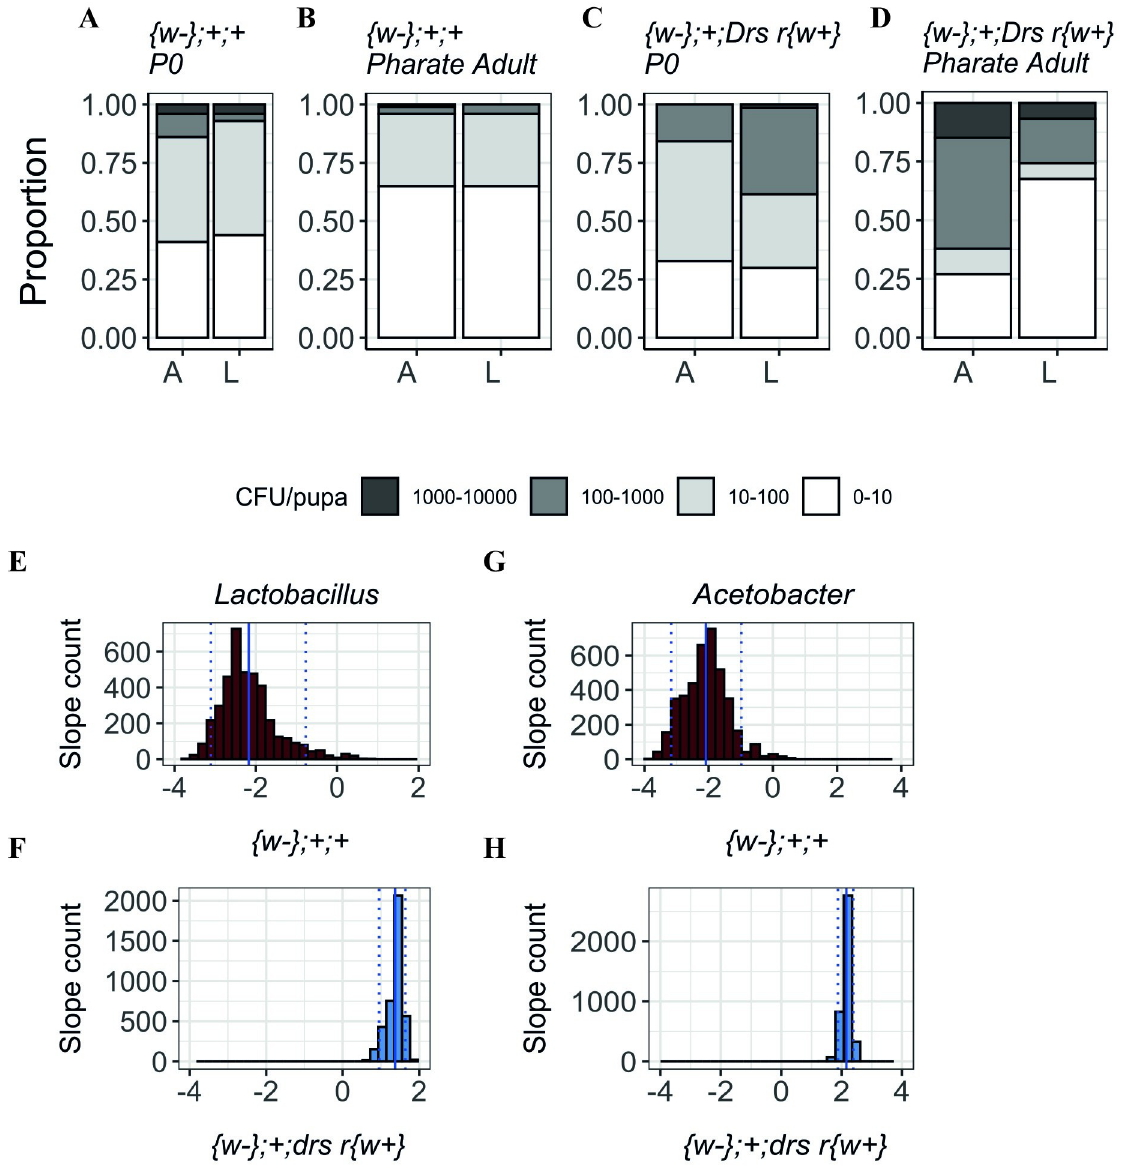
Fig 6. Bacteria quantification ( Lactobacillus (L) and Acetobacter (A)) in P0 pupae and pharate adults in wild-type and drs mutants. (A-B) In control flies ({w-} ;+;+), the number of pupae with more bacteria decreases between P0 and pharate adult stages. (C-D) In the drs mutant line ({w-} ;+; Drs r{w+}), there are more individuals with higher loads of bacteria persisting from P0 to pharate adult. (E-F) Slopes for the number of Lactobacilli in control and the mutant lines. (E) Control samples have negative slopes indicating a decrease in the number of bacteria between stages ( Median : -2 . 308 (IQR : -2 . 619; -1 . 880 ); One-way Wilcoxon test for median0: < 2.2e-16, r = 0.865). (F) drs mutant samples have positive slope values, representative of an increase in the number of bacteria across metamorphosis ( Median : 1 . 408 (IQR : 1 . 286; 1 . 498); One-way Wilcoxon test for median > 0 : < 2 . 2e-16 , r = 0 . 866 ). (G) Control samples distribution show negative slopes, i.e., a decrease in the number of bacteria between stages ( Median : -2 . 0 . 757 (IQR : -2 . 5721; -1 . 7128); One-way Wilcoxon test for median < 0 : < 2 . 2e-16 , r = 0 . 866 ). (H) drs null mutant displays positive slope values ( Median : 2 . 165 (IQR : 2 . 077; 2 . 247); One-way Wilcoxon test for median > 0 : < 2 . 2e-16 , r = 0 . 866 ). Doted lines represent the 0.05 and 0.95 quantiles; full line represents the mean slope. drsl2 expression are perturbed in the gut (Fig 8). Disrupting ecdysone signalling in the gut ( Mex > EcRDN ) has no impact on bacterial clearance as considerably higher numbers of indi- viduals are found in low bacterial load classes upon progression from L3 to P0 (Figs 8A,8D